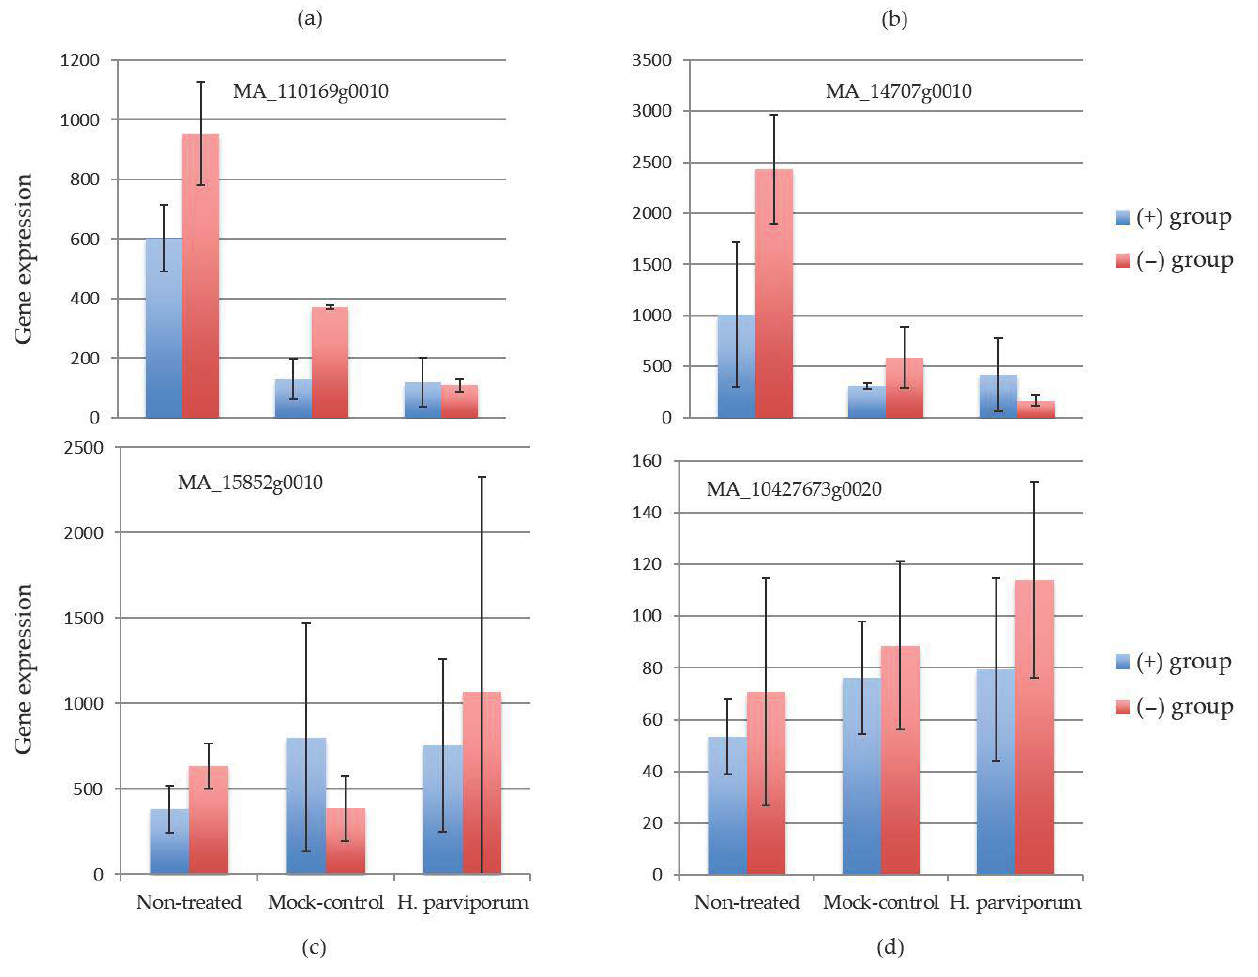
Figure 2. Heterobasidion resistance related genes and their expressions in each treatment (compared to (+) group non-treated). ( a ) MA_110169g0010 and ( b ) MA_14707g0010 were downregulated while ( c ) MA_15852g0010 and ( d ) MA_10427673g0020 were